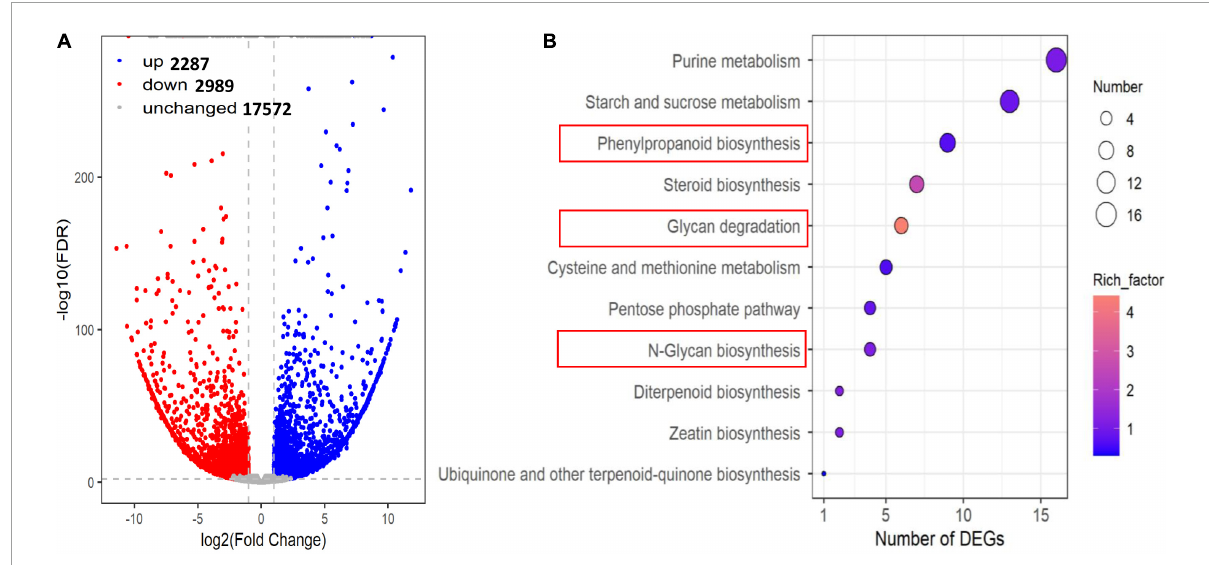
FIGURE5 Differentially expressed genes (DEGs) between J2416 and 5237. (A) Volcano plot of DEGs. Blue and red dots represent significantly up- and down-regulated genes, respectively, in J2416 compared with 5237. (B) KEGG pathways enriched with up-regulated genes in J2416.